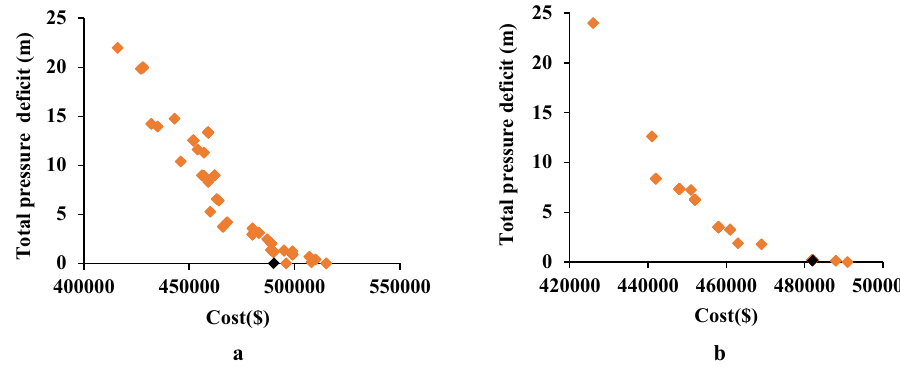
Fig. 4 Front of non-dominant solutions of two-loop WDN: a. pressure-dependent leakage and b. constant leakage